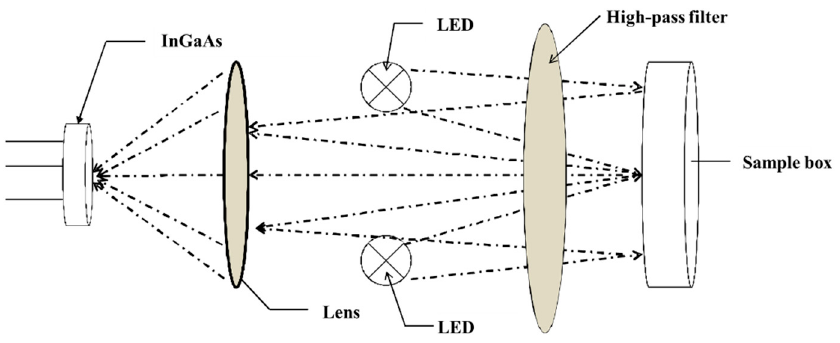
Figure 3. The schematic diagram and components of the sensor probe.